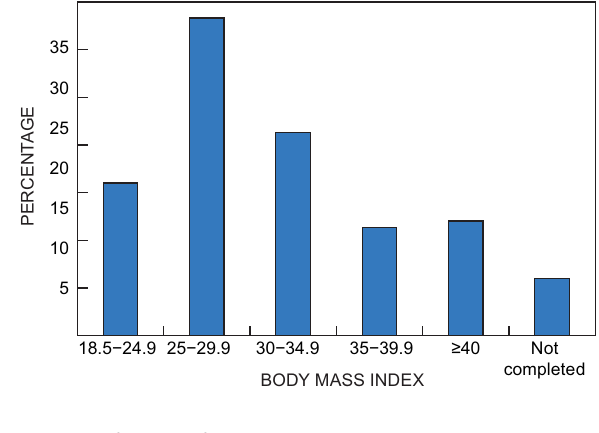
Figure 2: Body mass index.